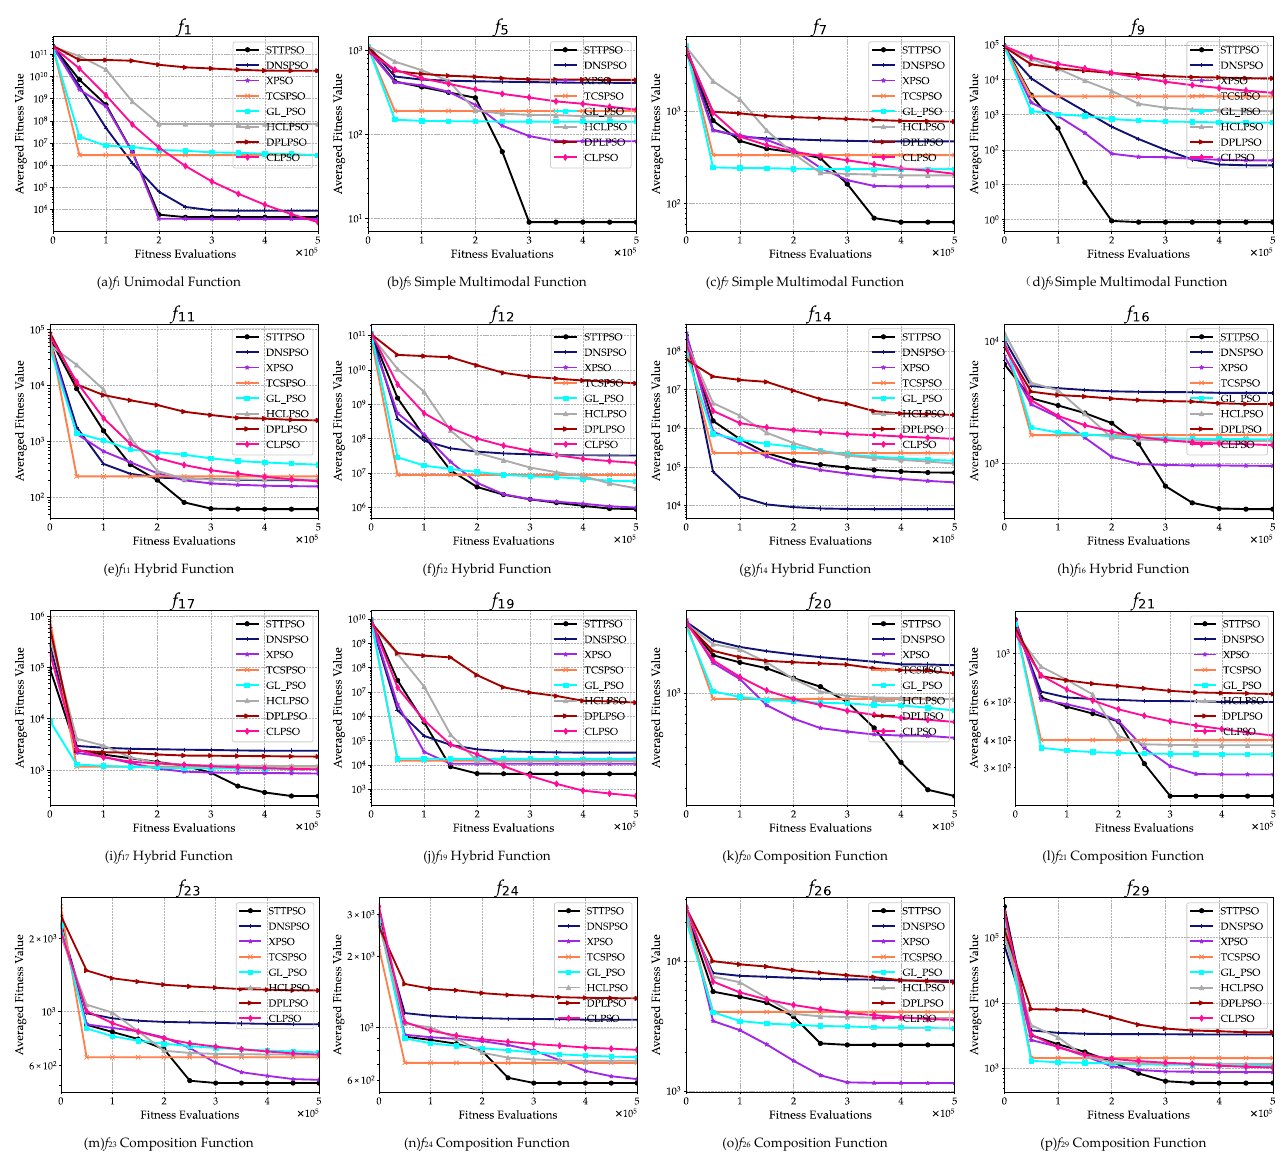
Figure 1. Convergence behavior comparisons between STTPSO and the seven compared algorithms on the 16 50 D CEC 2017 benchmark problems. Table 7. Comparison results between STTPSO with different settings of stagnation times on the 50 D CEC 2017 functions. The best results are highlighted in bold.